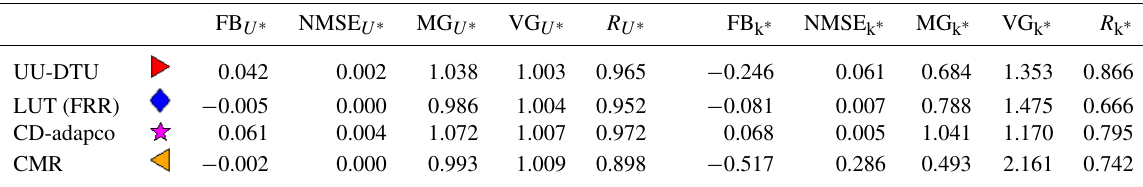
Figure 10. Normalized mean velocity U/U ref (a) and normalized turbulent kinetic energy k/U ref (b) in the wake x/D = 2.77 behind T1 measured for test case C. The upstream turbine T1 is operated at λ T1 = 6.0. The reference velocity U ref = 11.5ms − 1 is the velocity experienced by T1 at hub height. Table 8. Statistical performance measures FB, NMSE, MG, VG and R of the normalized mean velocity U ∗ and normalized turbulent kinetic energy k ∗ predictions of the four different models for test case C. The wake flow is predicted at stream-wise measurement position x/D = 2.77 downstream of